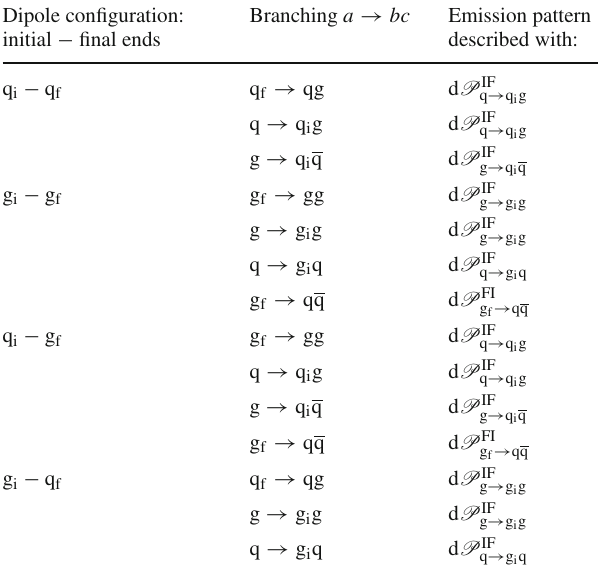
Table 2 The four configurations of an original FI/IF dipole, with all the branchings that can occur for it. The probability of emission which is used to describe the branching has been specified Dipole configuration: Branching a → bc Emission pattern initial − final ends described